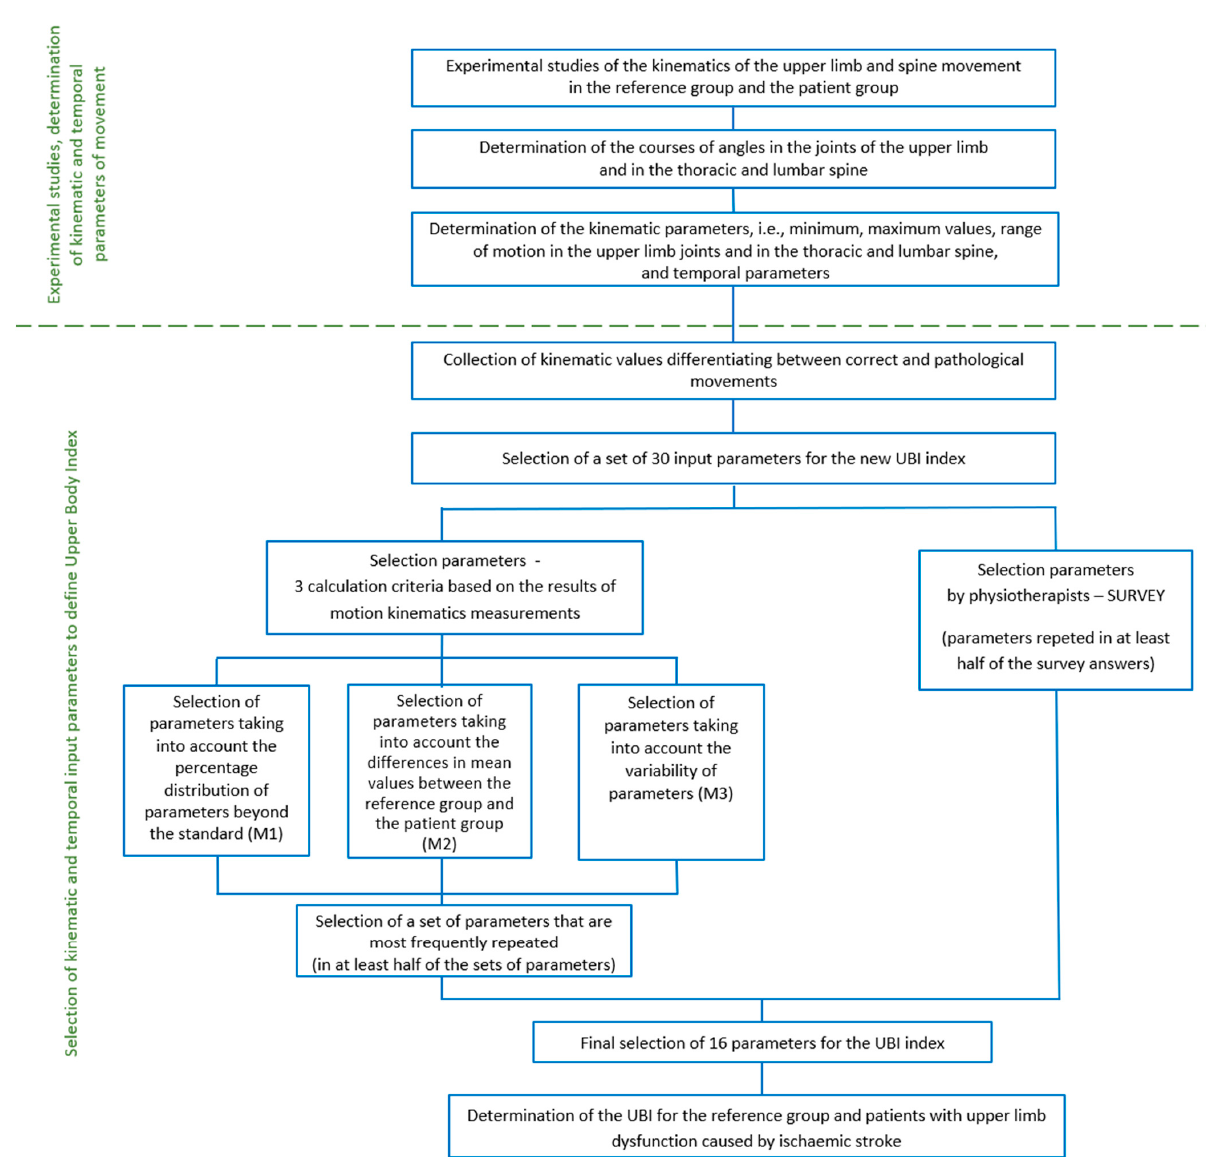
Figure 1. Flowchart illustrating the successive steps to develop a methodology for assessing upper limb manipulative function from kinematic data of activities of daily living using the PCA algorithm.